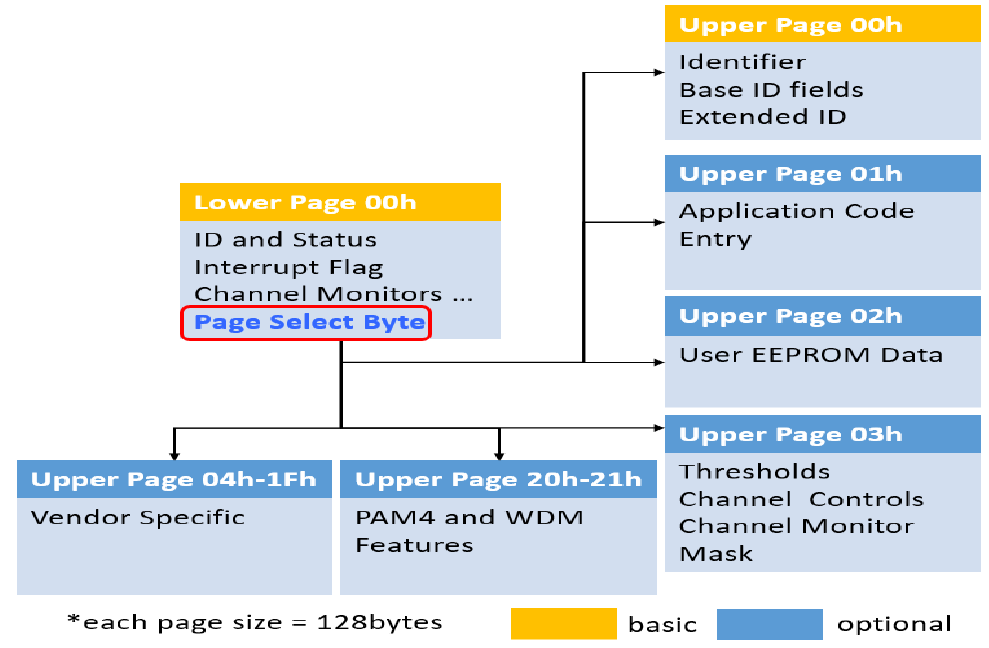
Figure 4. QSFP28 internal register architecture and page accessing